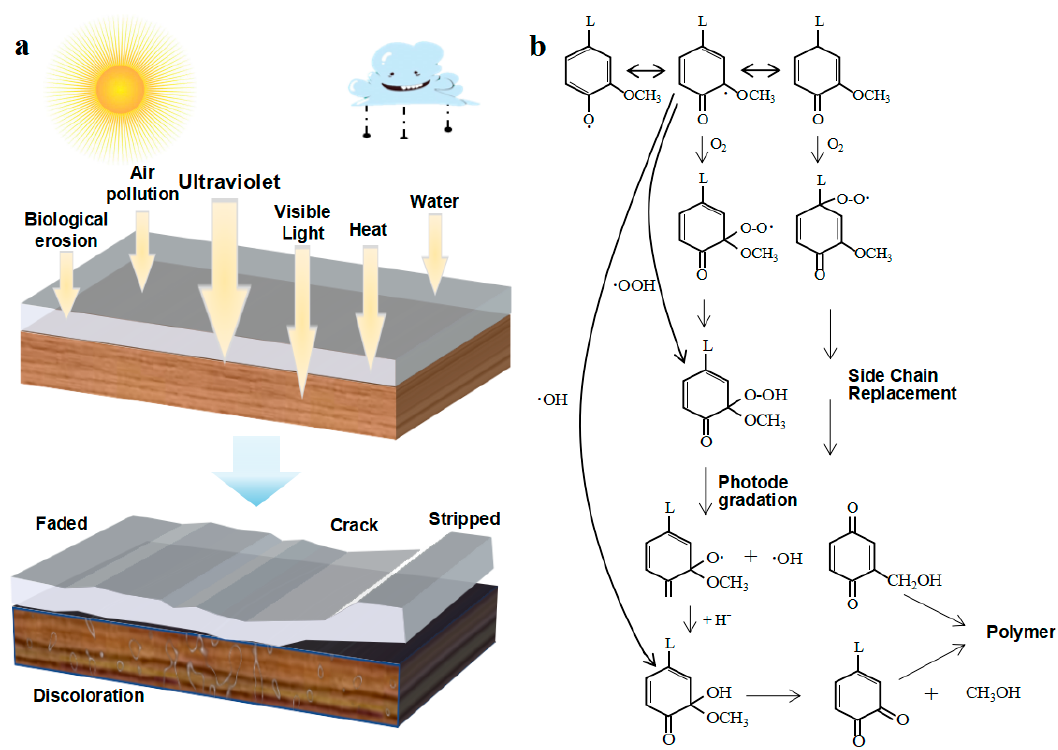
Figure 1. ( a ) The factors affecting wood and coating degradation; ( b ) α -Quinone and β -quinone forming from initial phenoxy radical.